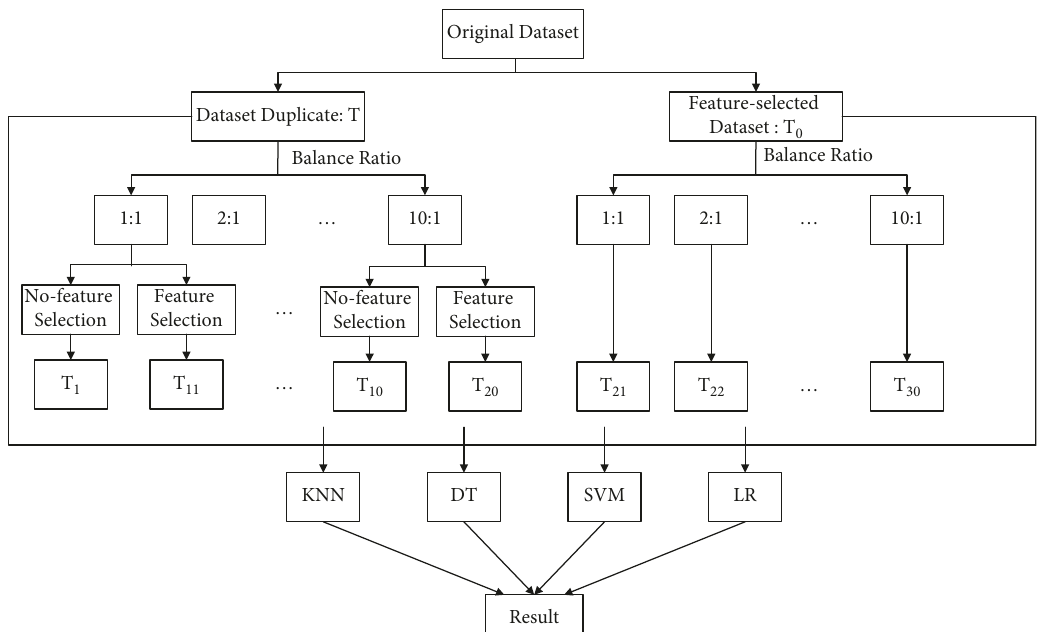
Figure 11: Flowchart of the comprehensive metric model based on multimachine learning